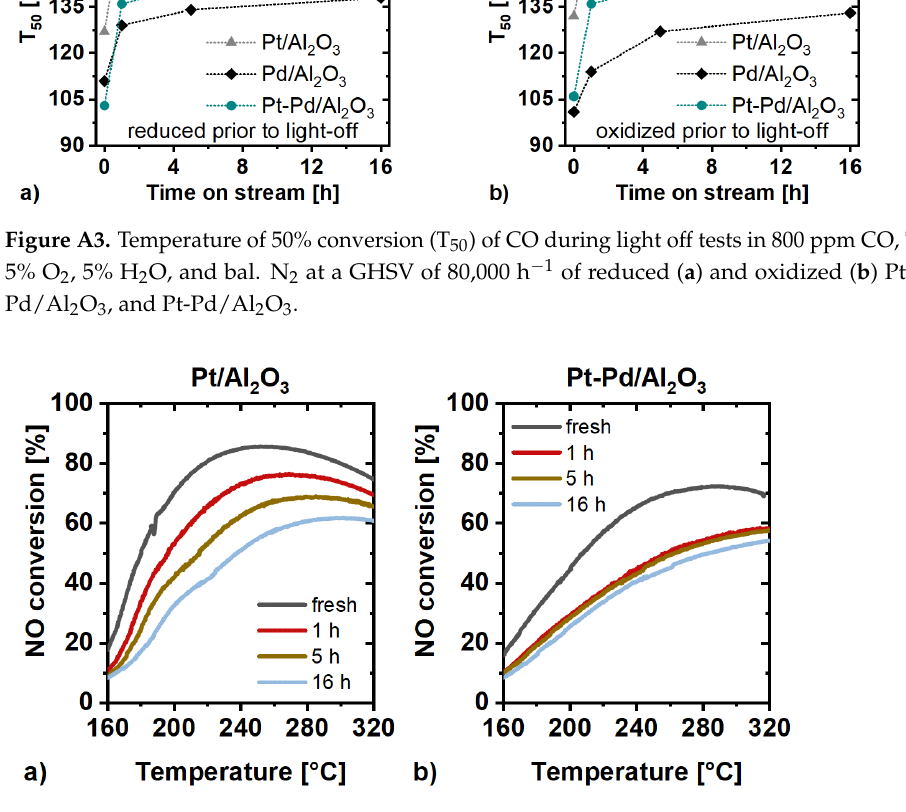
Figure A4. Catalytic activity for NO conversion after oxidative pretreatment of Pt/Al 2 O 3 ( a ), and Pt-Pd/Al 2 O 3 ( b ) during a light-off test in 800 ppm NO, 7% CO 2 , 5% O 2 , 5% H 2 O, and bal. N 2 at a GHSV of 40 000 h − 1 .